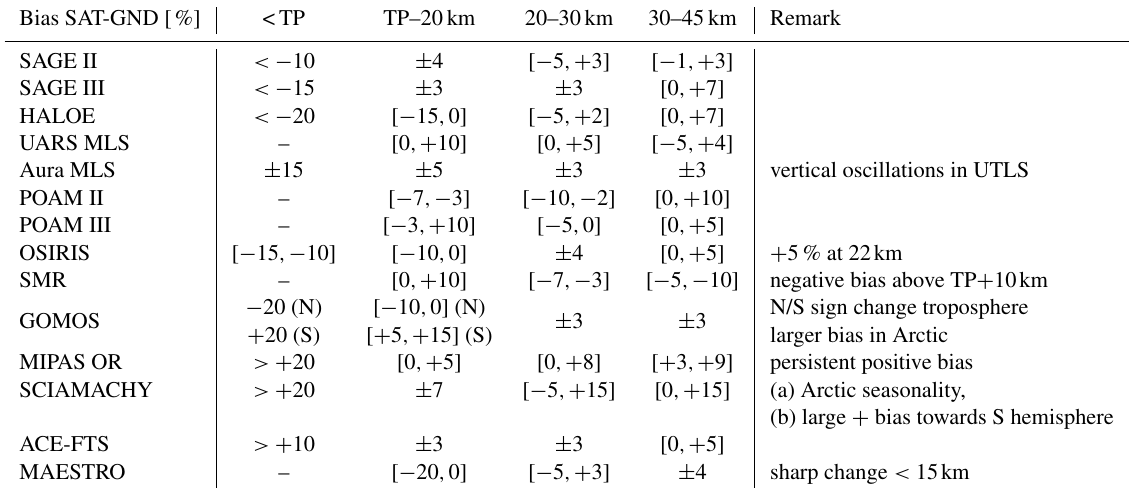
Table 5. Overview of the bias of satellite ozone profile records relative to ozonesonde and lidar, in the upper troposphere and stratosphere. We present the range of the median relative difference (bias b ) in each altitude bin, and whether there are any dependences on latitude and season that depart from the general